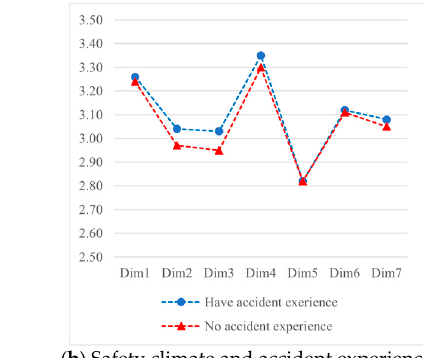
Figure 4. Safety climate scores based on working ( a ) position and ( b ) length of work.